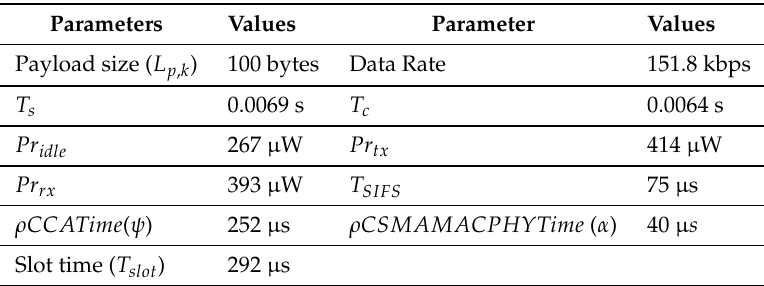
Table 2. Parameters used in performance evaluation and